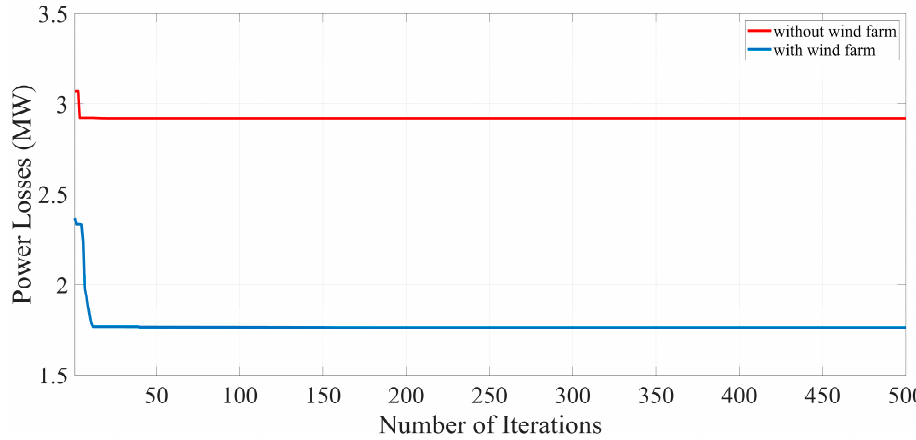
Figure 5. The convergence curves for the minimization of power losses across the transmission lines for the Test System 1.